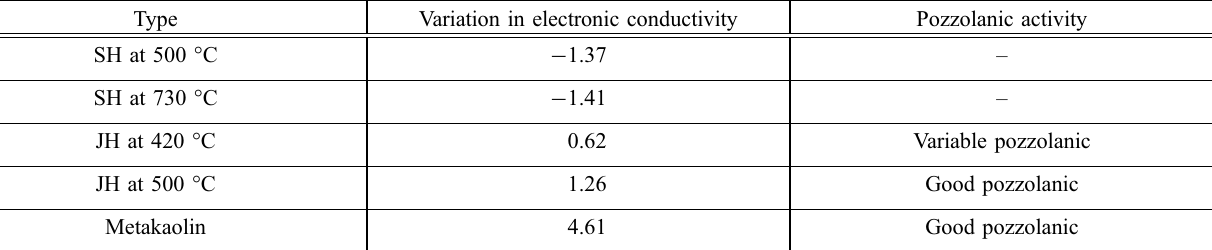
Table 4 The difference between the initial value and the electric conductivity after 2 min of metakaolin and heat treated dredged sea soil.